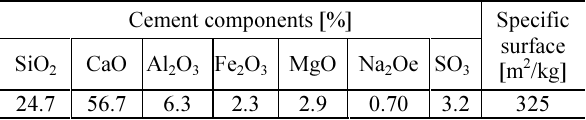
Table 6. Chemical characteristics of CEM II/ B-S 32.5 R